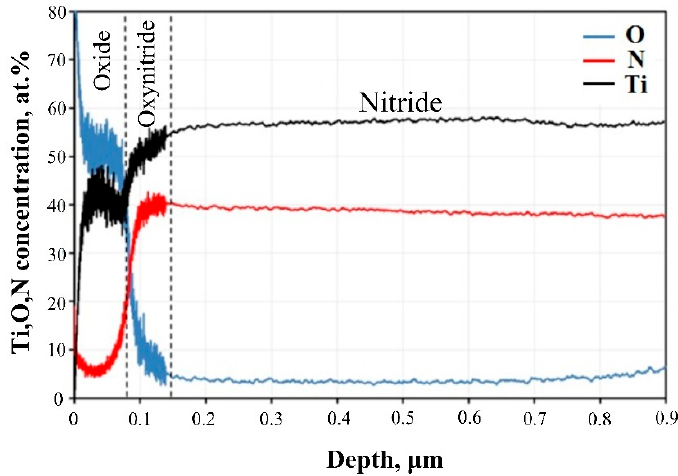
Figure 3. Depth profiles of Ti, O, and N in TiN / TiO 2 coating deposited on Co–Cr substrate without electron beam treatment.